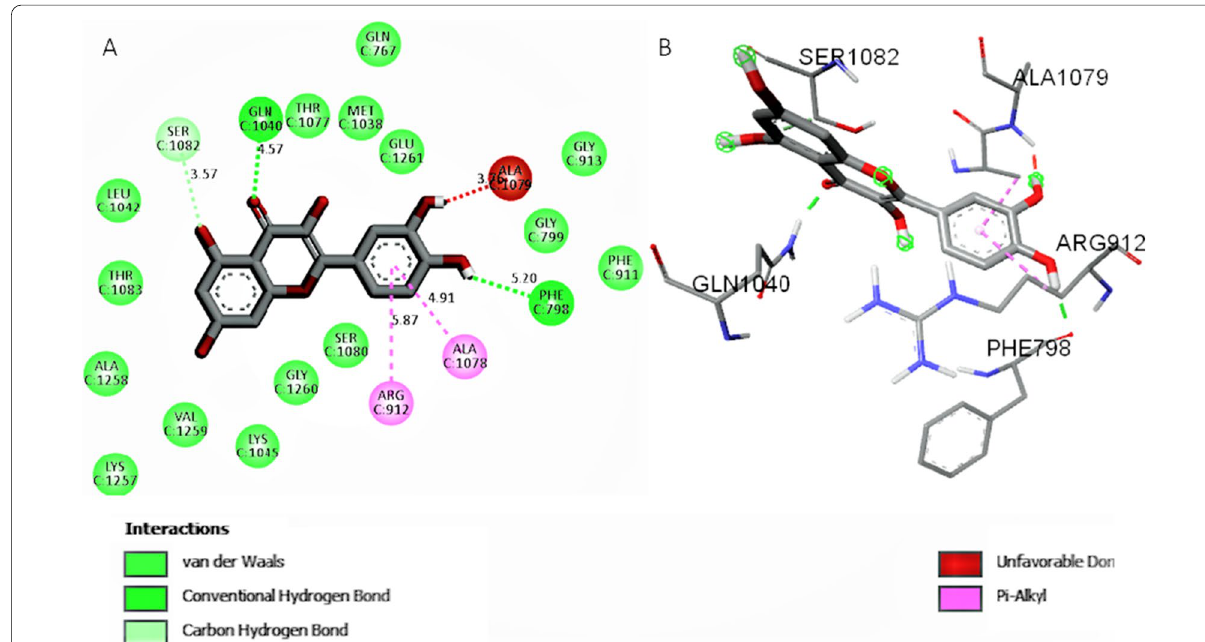
Fig. 8 2D ( A ) and 3D ( B ) simulations of quercetin–XOD active site supramolecular bondings, showing a substrate-binding consequential pi-alkyl interaction with ARG912